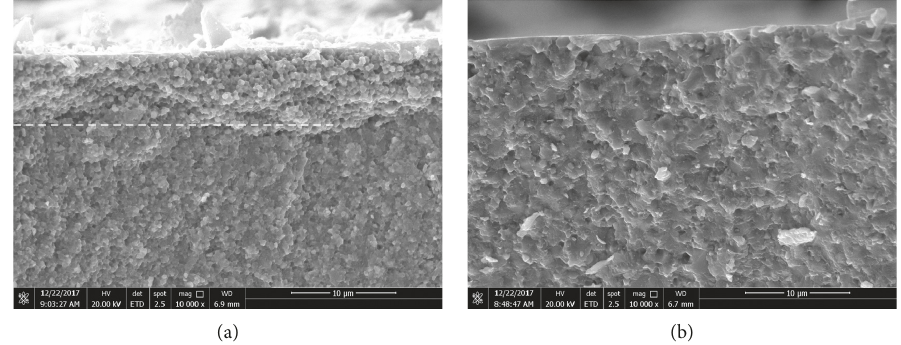
Figure 2: Fracture surfaces of specimens after aging for 20h: (a) SuperfectZir HTS and (b) Katana HT. The region transformed due to the hydrothermal aging is indicated by the dashed